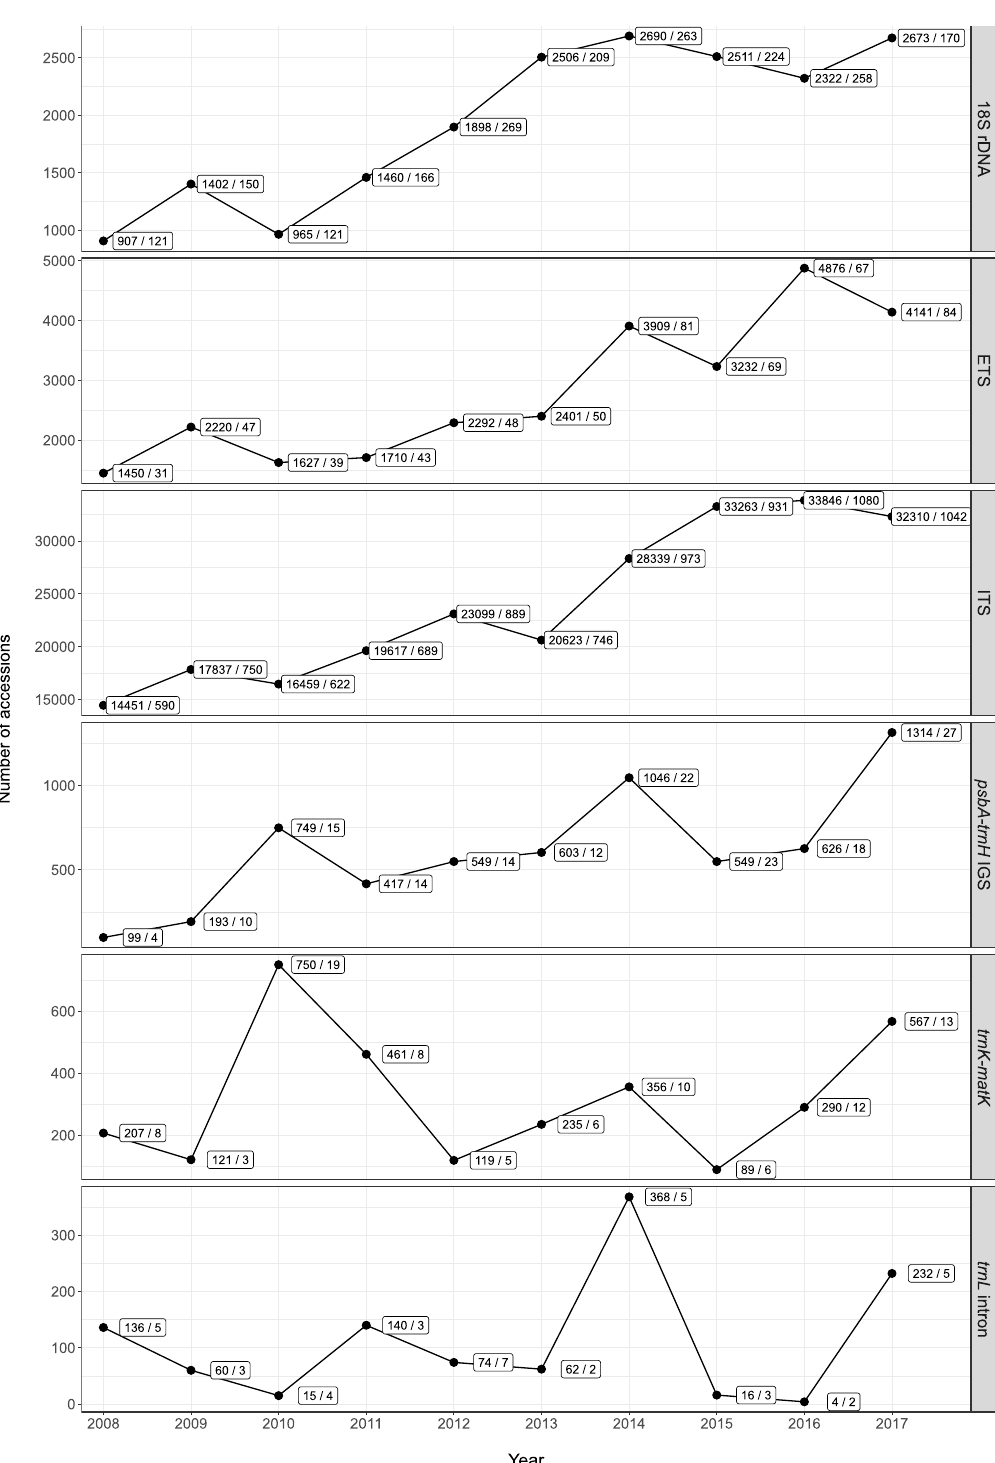
Fig 1. The number of DNA sequences of ENA’s plant taxonomic division (PLN) of the standard annotated assembled sequence data class (STD) released on ENA per calendar year, displayed by type of DNA barcoding marker. Each count of released DNA sequences is followed by the total number of investigations that the sequences are associated with; the two numbers are separated by a forward slash. Due to the daily synchronization of sequence records between GenBank, ENA, and DDBJ, the release numbers are identical across all three